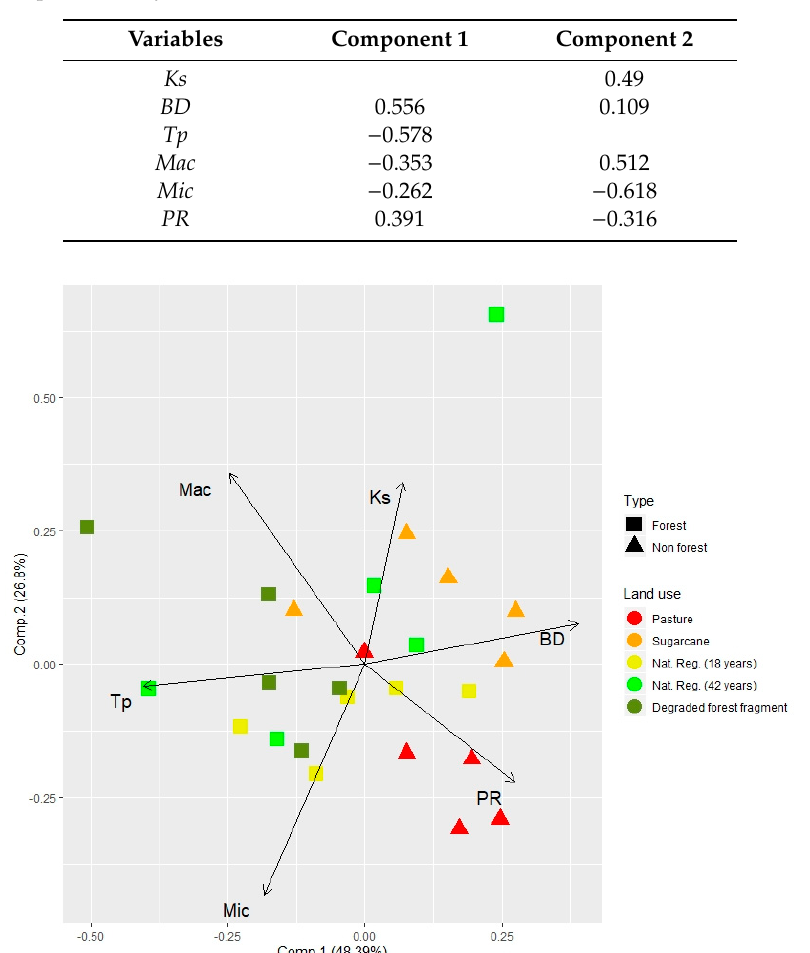
Table 3. Principal component analysis (PCA) loadings for the first and second components of the principal component analysis.